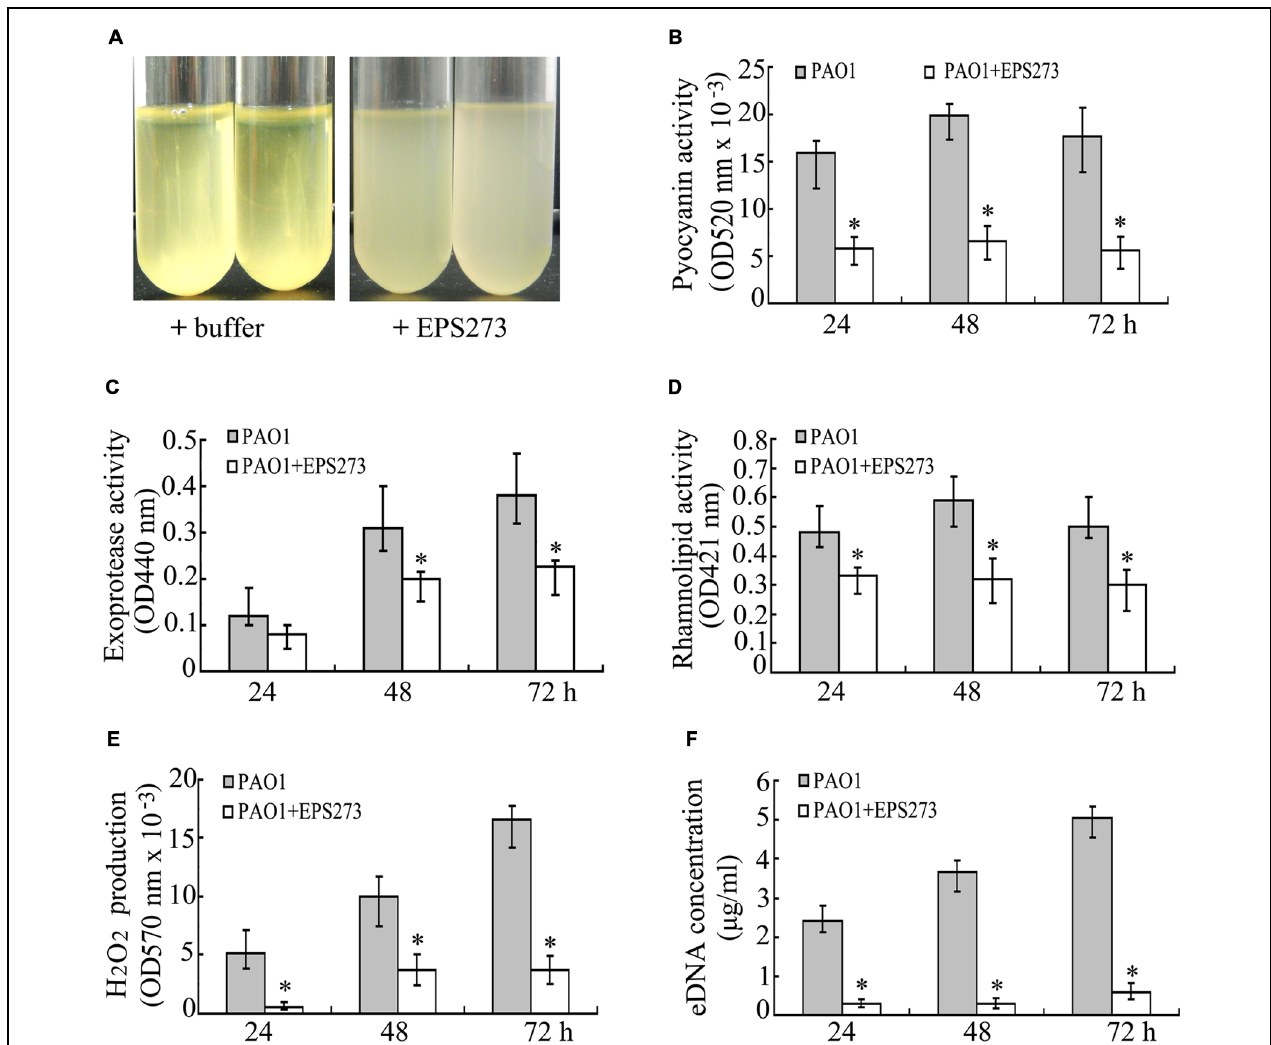
FIGURE 5 | Effects of EPS273 on intercellular adhesion (A), the production of pyocyanin (B), exoprotease (C), rhamnolipid (D), hydrogen peroxide (H 2 O 2 ) (E) and extracellular DNA (eDNA) (F) of P. aeruginosa PAO1. The concentration of EPS273 used in the above assays is 0.1 µ g/mL. Error bars indicate the standard deviations of three measurements. ∗ P < 0.05 versus the